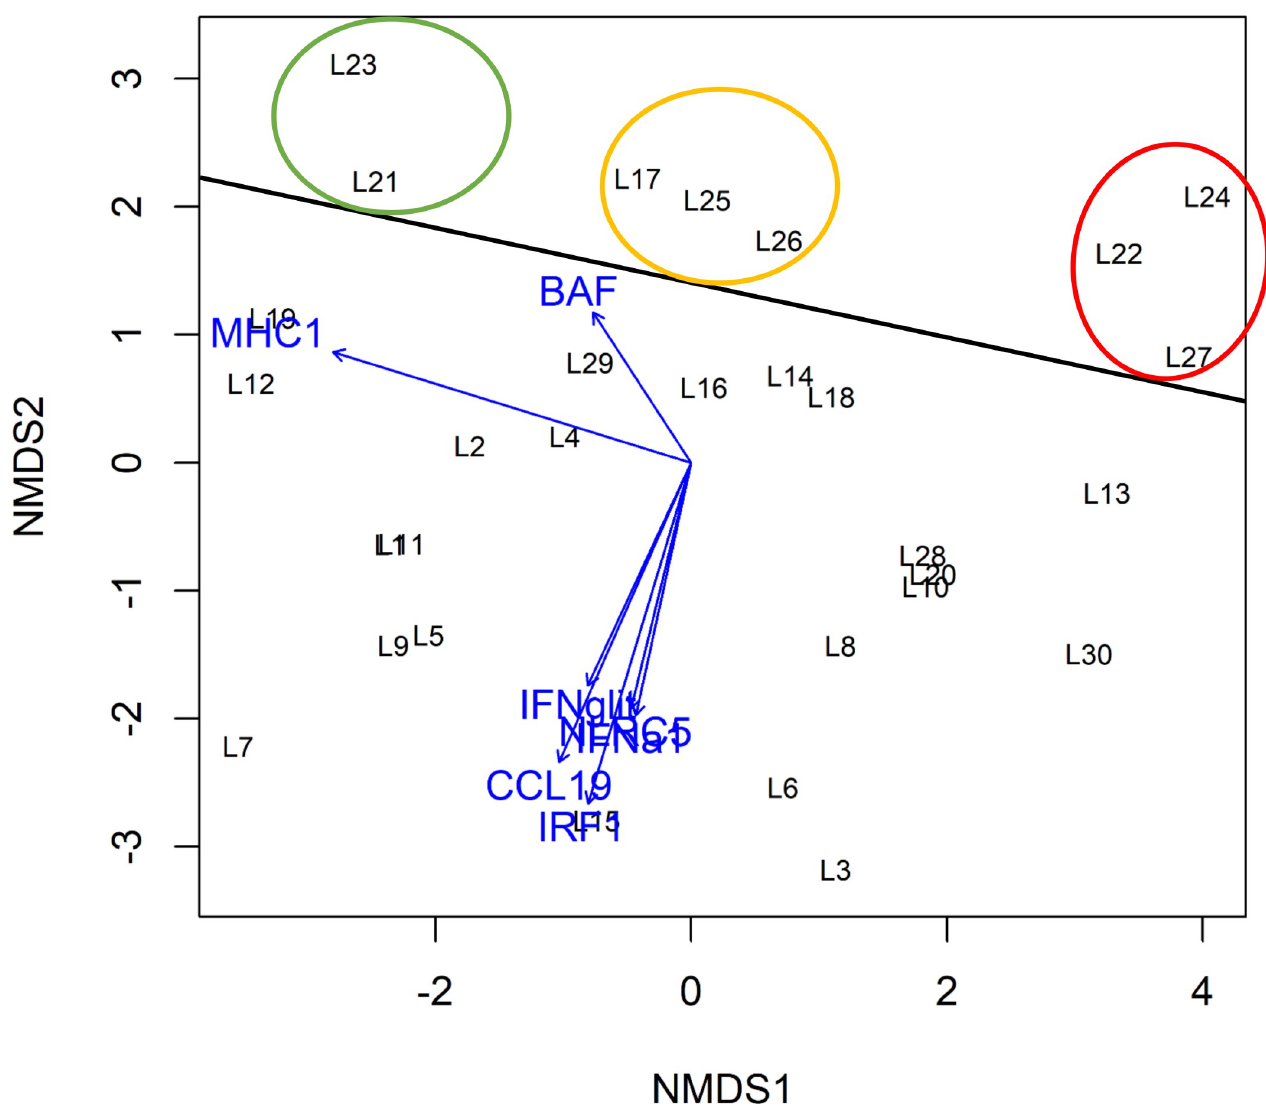
Fig 5. Result of the nonparametric multidimensional scaling (NMDS) with immune response genes (IRG) gene expression profiles of 30 liver samples (L1 to L30). The genes BAF , CCL19 , NLRC5 , IRF-1 , IFNa1 und IFN-g were most strongly upregulated in the samples L27, L21, L22, L23, L24, L25, L26 and L27 displayed above the black horizontal line. The circles refer to the degree of MHC-I regulation of those samples: strongly downregulated (green circle), slightly upregulated (orange circle) and strongly upregulated (red circle) according to IRG expression profiles.